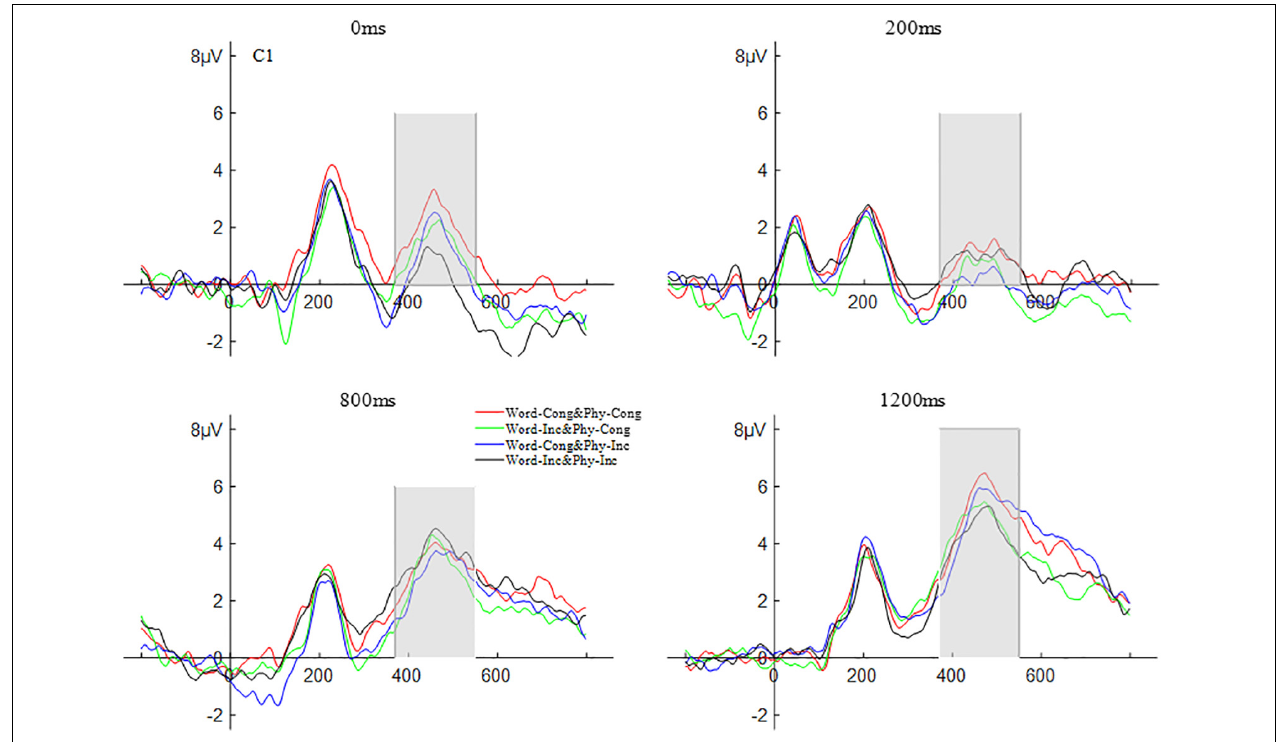
FIGURE 5 | The waveform of P3 word and physical congruency under different stimulus onset asynchrony